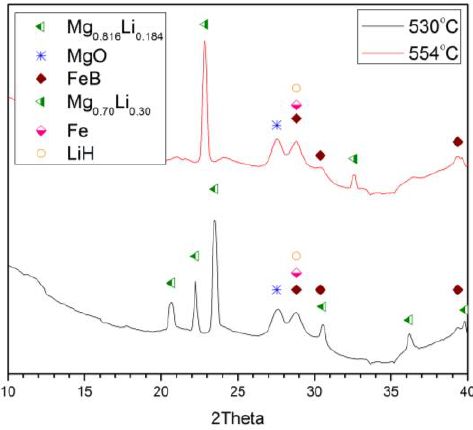
Figure 6. Transformation of Mg 0.816 Li 0.184 into Mg 0.70 Li 0.30 .